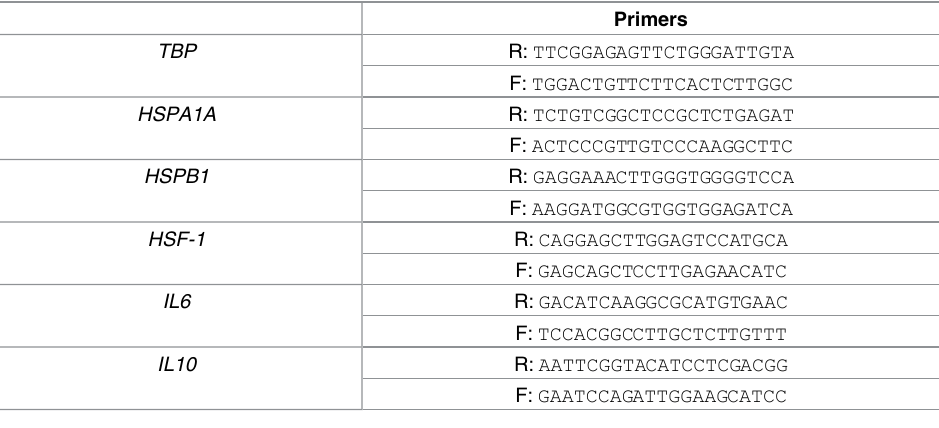
Table 2. Primers used in PCR